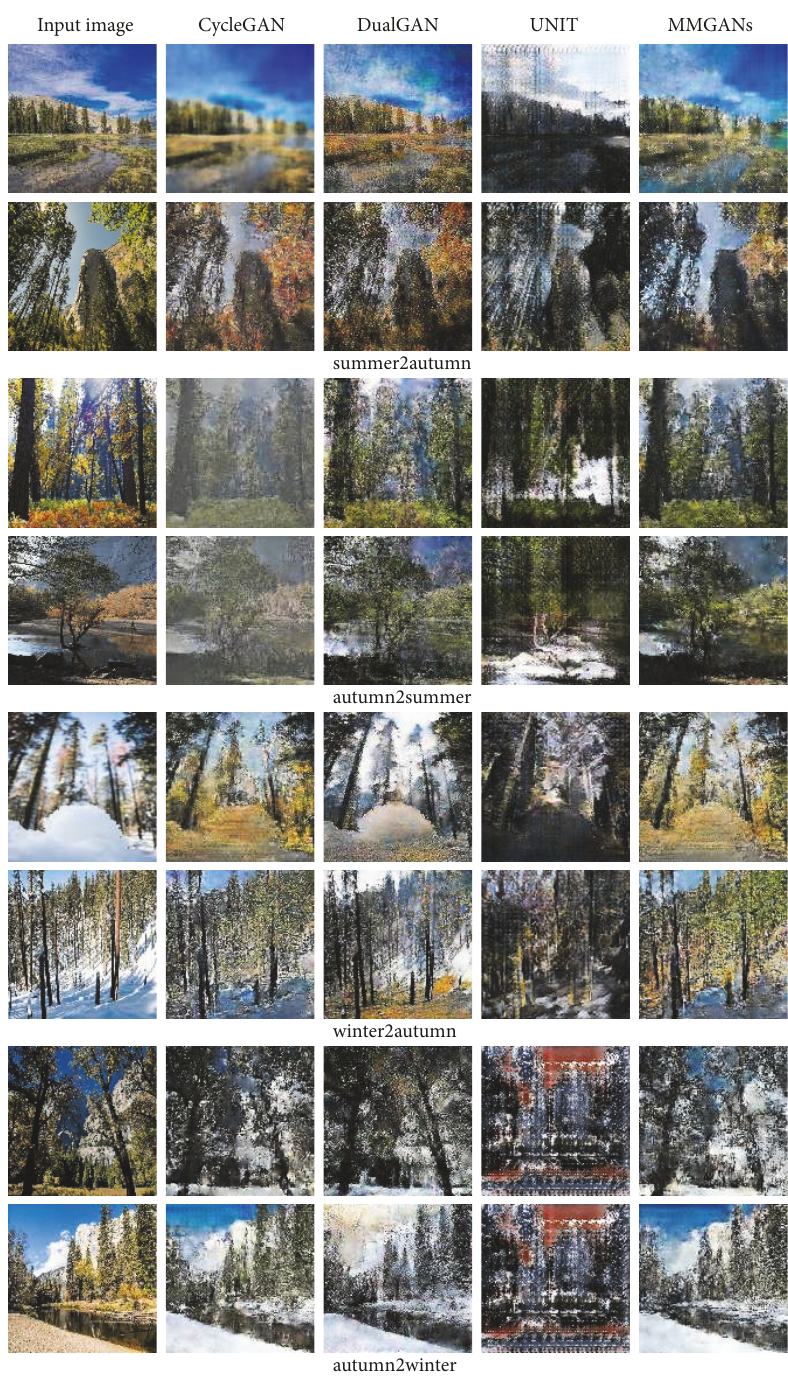
Figure 6: Generated images from test datasets (continuous). The left column is input image, then generated images with CycleGAN, DualGAN, UNIT, and MMGANs,